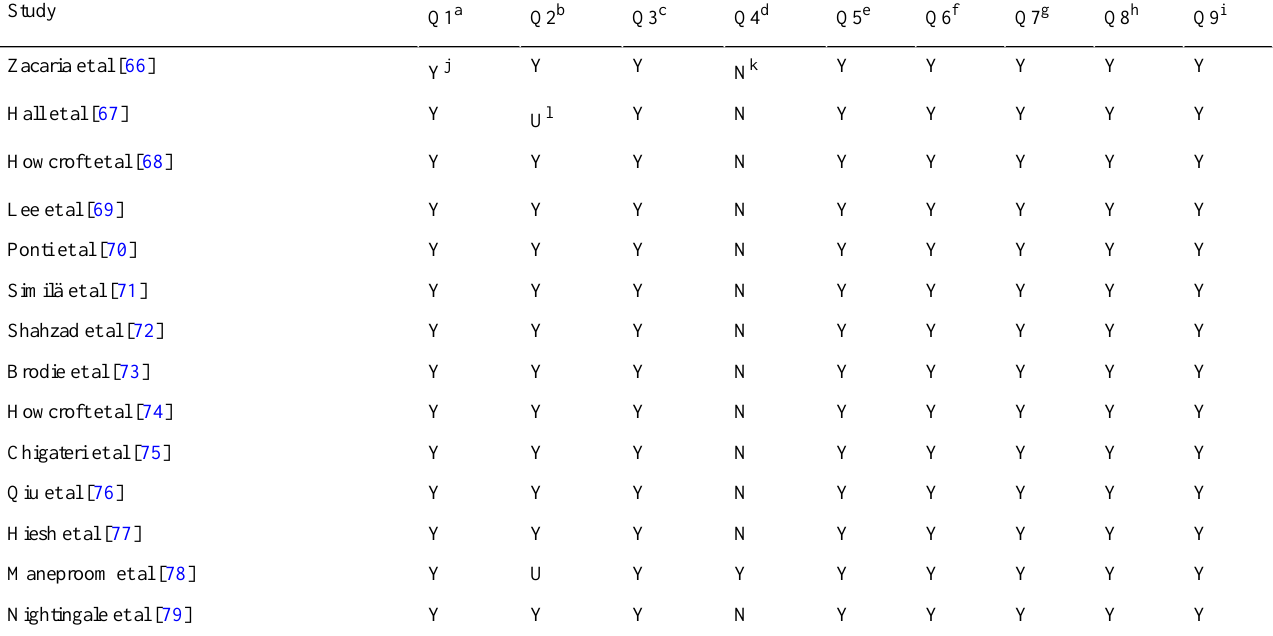
Table 4. Methodological quality of quasiexperimental studies based on the Joanna Briggs Institute Critical Appraisal